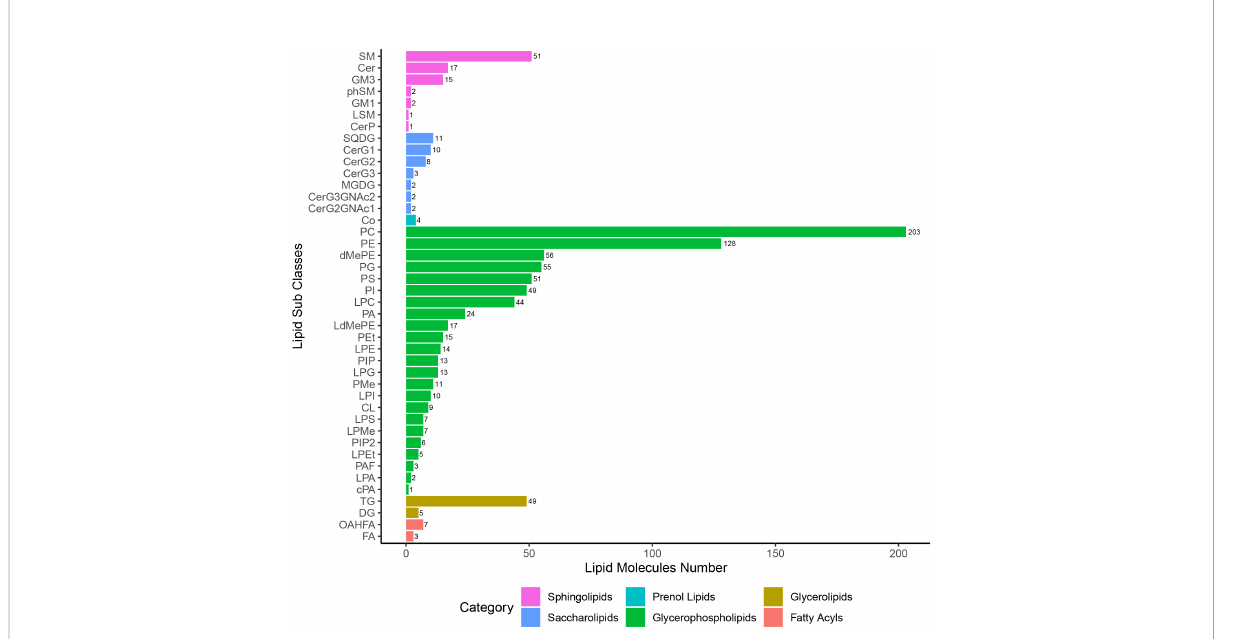
FIGURE 2 The lipid subclasses/categories and the corresponding number of lipid species per